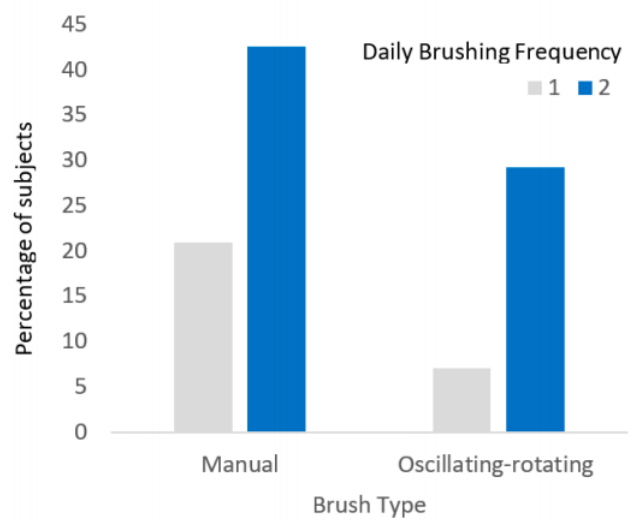
Figure 1. Distribution of Daily Brushing Frequency by Brush